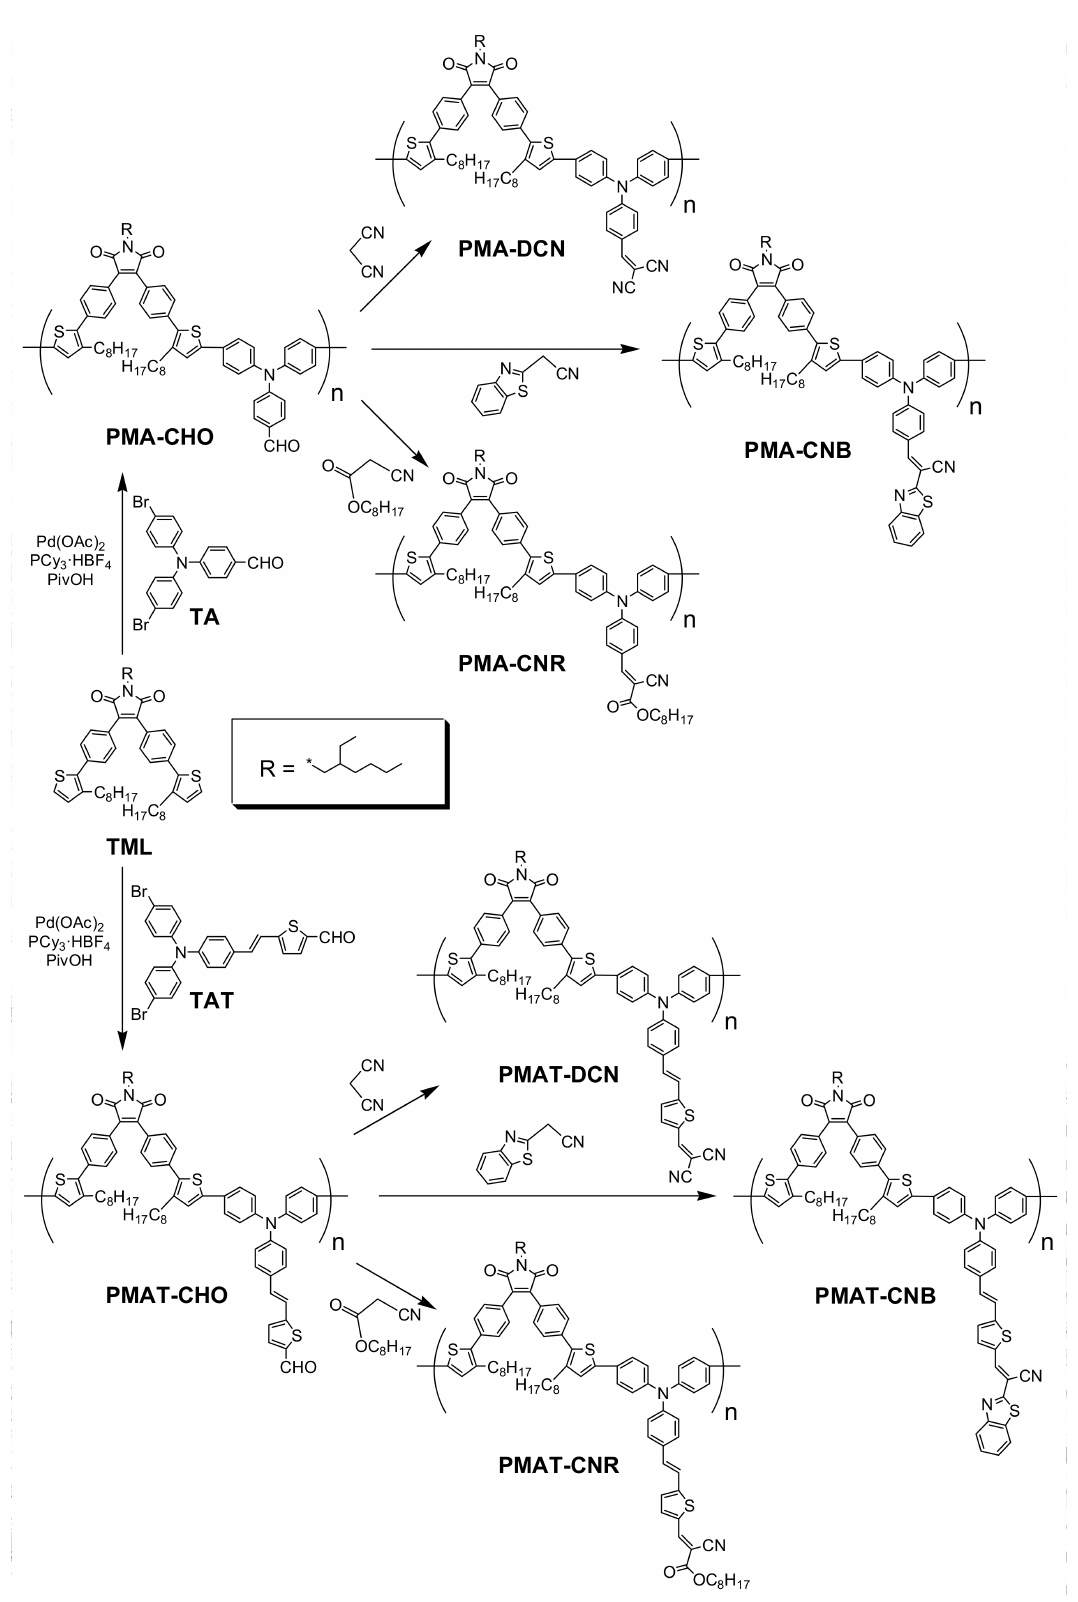
Scheme 1. Synthetic scheme for PMA- and PMAT-series